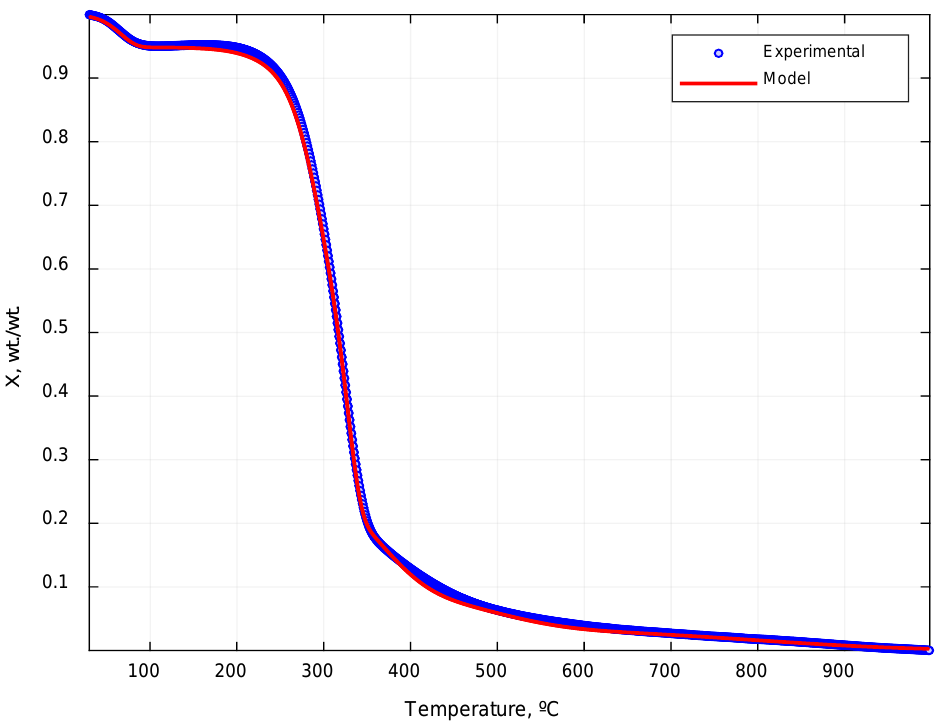
Figure 11. Model fitted to the experimental willow TG curve. Processes 2020 , 8 , x FOR PEER REVIEW